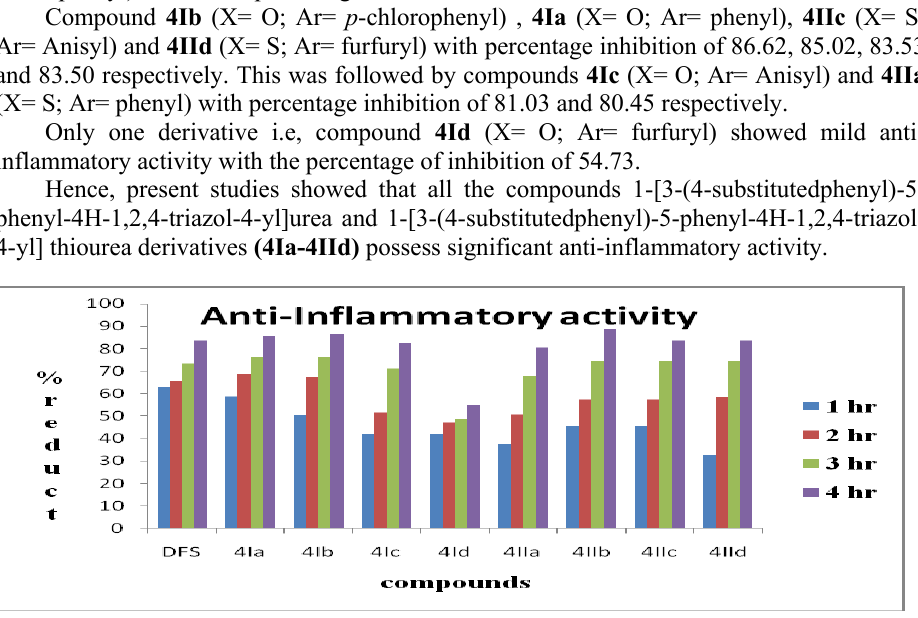
Figure 1. Graphical representation of percentage inhibition of paw volume of 1-[3-(4- substitutedphenyl)-5-phenyl-4H-1,2,4-triazol-4-yl]urea and 1-[3-(4-substitutedphenyl)-5- phenyl-4H-1,2,4-triazol-4-yl] thiourea derivatives ( 4Ia-4IId ) by carrageenan induced rat paw edema